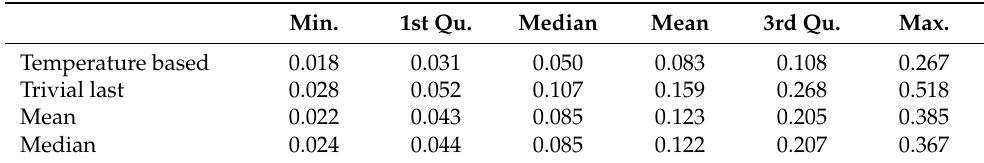
Table 3. Short-term prediction error (RMSE) of gas consumption (m 3 )—analysis of 19 tanks, 7-day prediction horizon. Min. 1st Qu. Median Mean 3rd Qu.